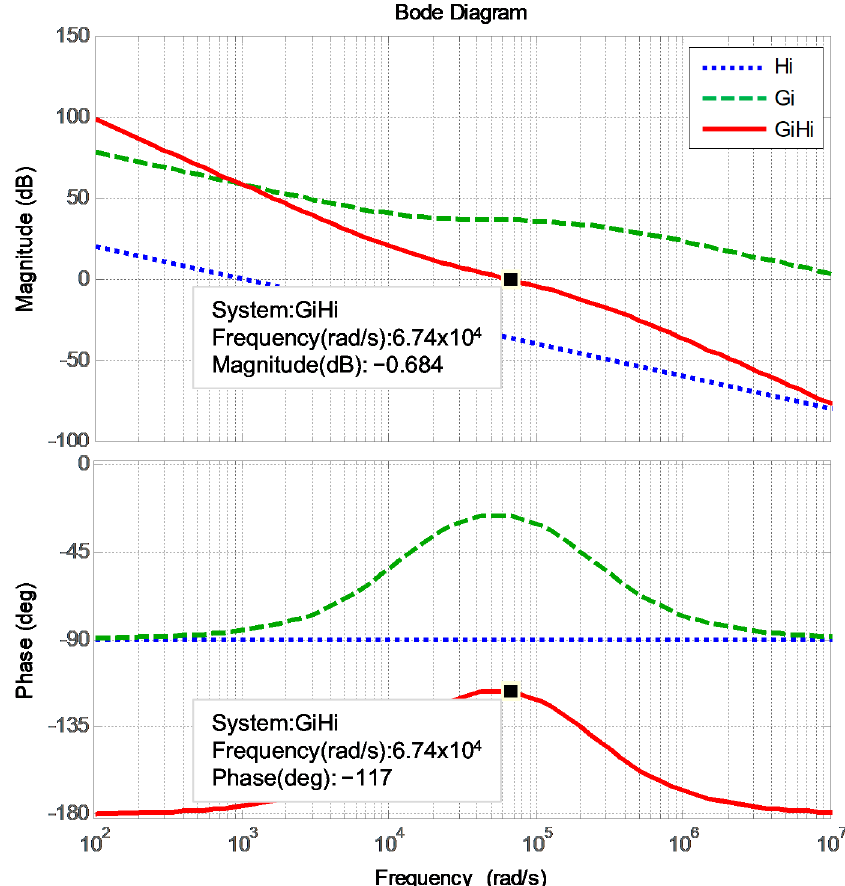
Figure 6. Bode plot of the two inductor current control loops.